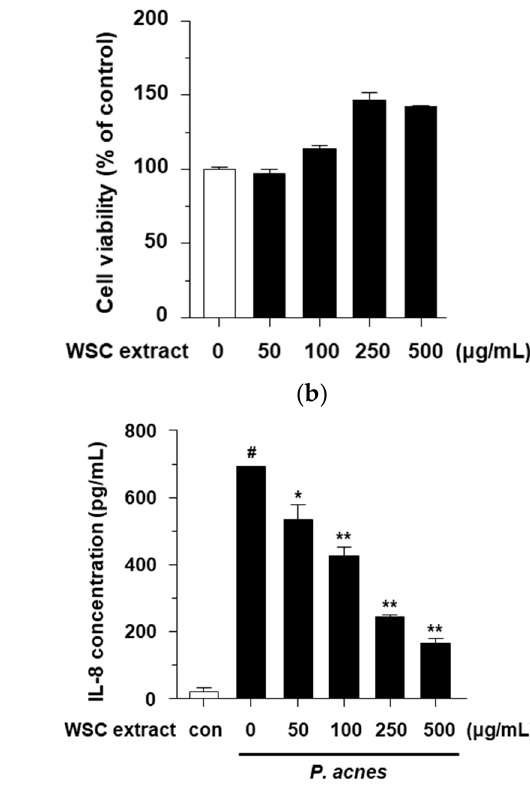
Figure 5. Effect of the WSC extract on MAPK signaling and nuclear translocation of NF- κ B in LPS-treated RAW264.7 cells. The cells were pretreated with the indicated concentrations of the WSC extract for 3 h and then treated with 1 μ g/mL of LPS for 30 min: ( a ) The protein levels of total and phosphorylated p38, JNK and ERK were determined via western blotting assays; ( b ) The protein levels of I κ B- α and NF- κ B p65 in cytosolic and nuclear fractions were determined via western blotting assays; ( c ) Localizations of nuclei and NF- κ B p65 were visualized following immunofluorescence staining.